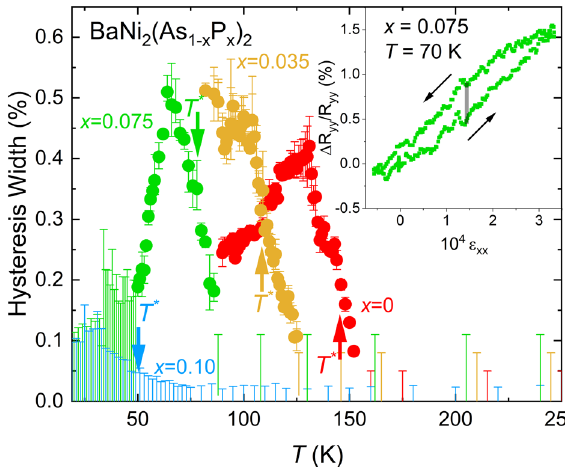
Fig. 4 Elastoresistance hysteresis as a function of P-substitution. Temperature dependence of the hysteresis width for the indicated compositions. The inset shows the de fi nition of the hysteresis width, i.e., the maximum difference between the up and down strain sweeps, shown here for x = 0.075 at T = 70 K in the transverse geometry. For a given x value, the hysteresis width shown corresponds to the (transverse or longitudinal) measurement with the best signal-to-noise ratio. At any given temperature we report the value obtained from an average of several strain sweeps, the positive (resp. negative) error bars are extracted from the maximal (resp. minimal) value of individual strain sweeps. At temperatures where no hysteresis is resolved, the hysteresis width has to be smaller than the experimental noise and this is shown as a positive error bar extending down to zero. The arrows indicate the corresponding T * temperatures of maximum m 12 − m 11 (see Fig. 3). For x = 0.10 no fi nite hysteresis is resolved down to the